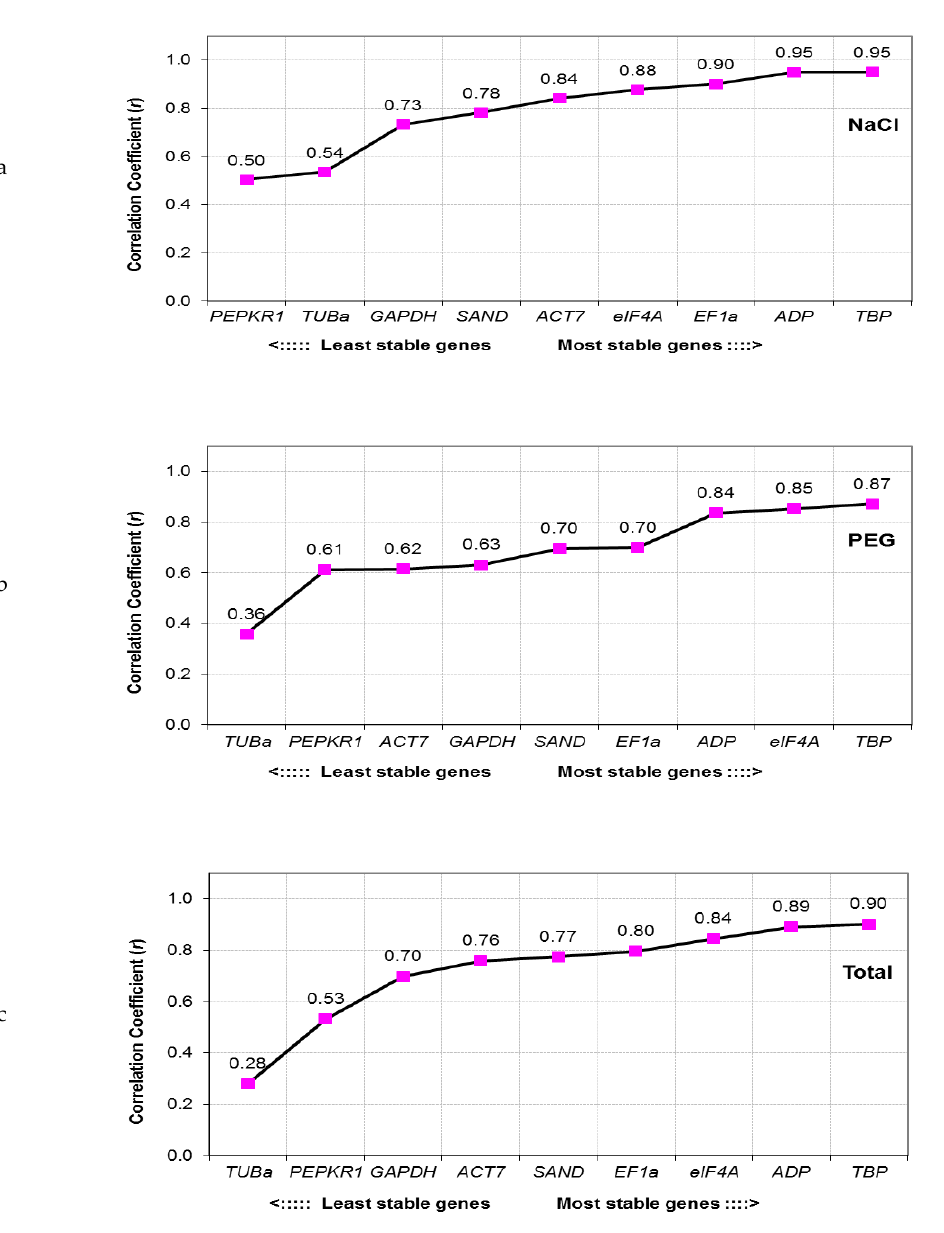
Figure 4. Determination of the most stable reference genes based on their correlation coefficients ( r ) according to the BestKeeper algorithm. The higher the correlation coefficient, the more stable is the gene’s expression. Analysis was performed separately for a) NaCl treated samples (NaCl), b) PEG treated samples (PEG) and c) all samples combined together (Total).